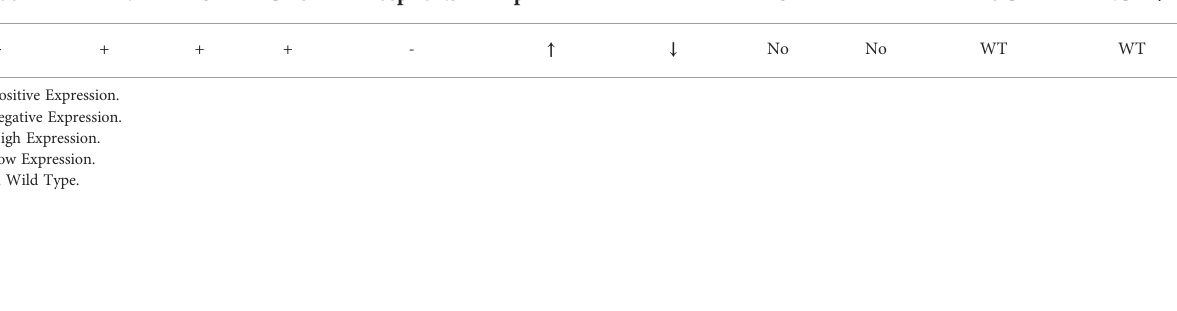
TABLE 1 A summary of the results of the patient ’ s protein expression.